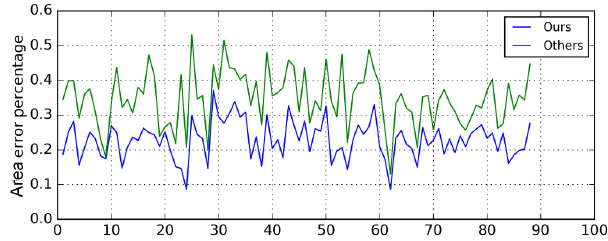
Fig. 12 Area errors for our algorithm and the method in Ref. [21].